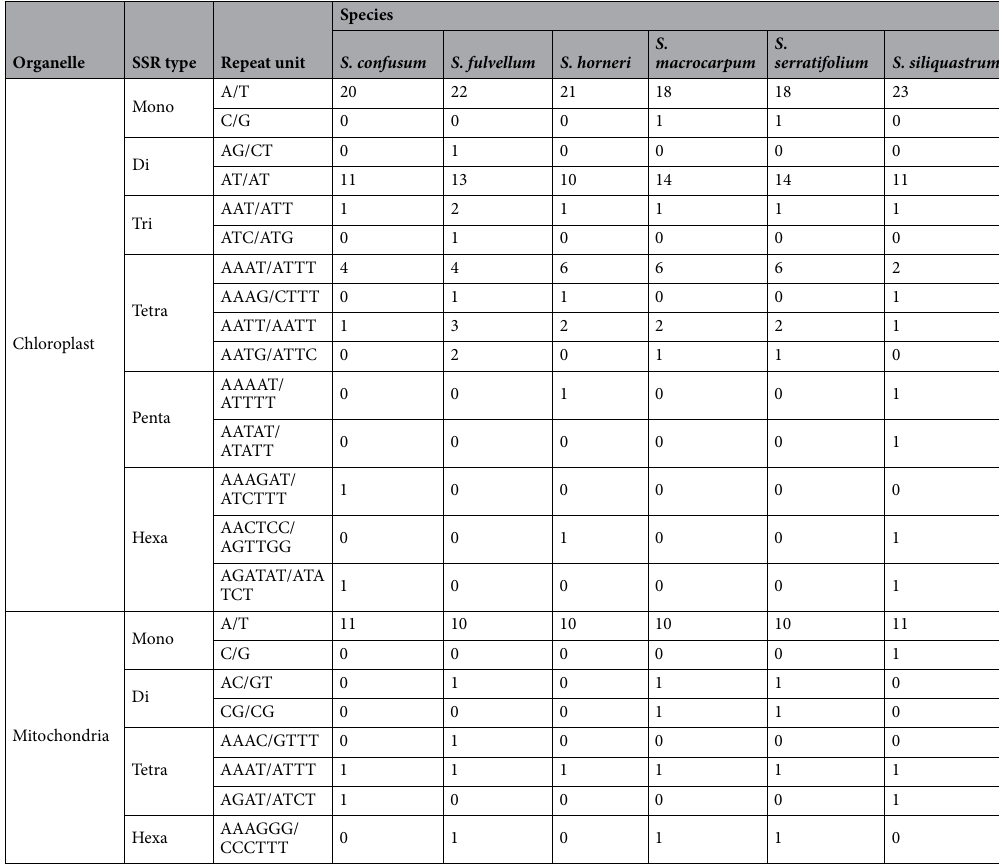
Table 2. Types and numbers of SSRs in the organellar genomes of six Sargassum